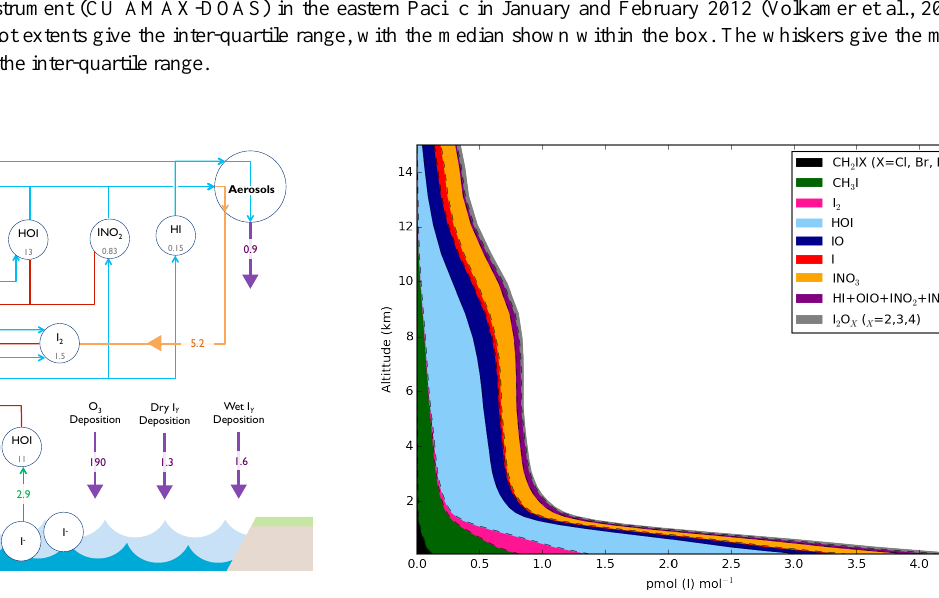
Figure 8. Global annual mean gas-phase iodine speciation with al- titude in the simulation with both iodine and bromine chemistry (“Br + I”). Mixing ratios are shown in pmolmol − 1 , with higher iodine oxides (I 2 O X ( X = 2, 3, 4)) and di-halogenated organics (CH 2 I X ( X = Cl, Br, I))